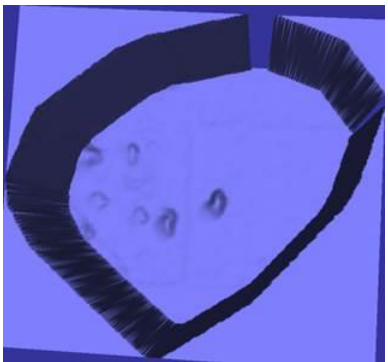
Figure 9. DEM image of the sampling area